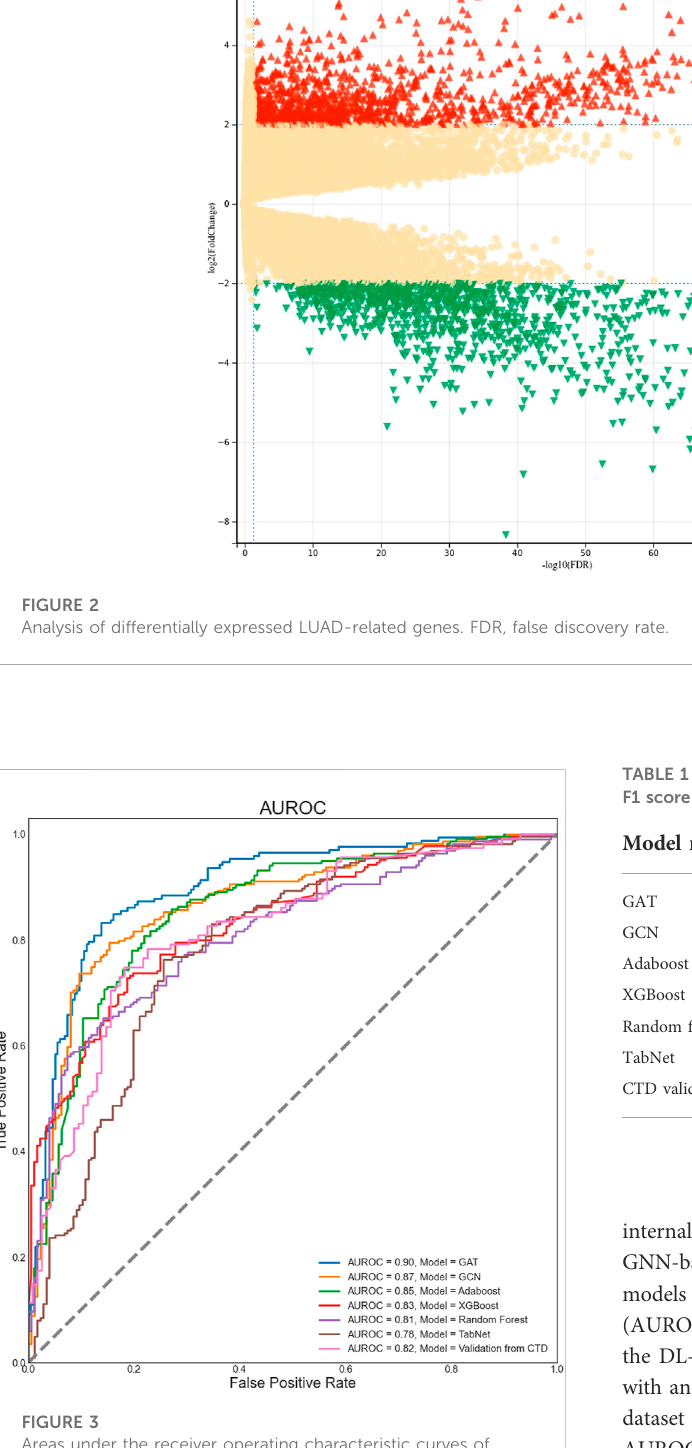
FIGURE 3 Areas under the receiver operating characteristic curves of the models. AUROC, area under the receiver operating characteristic curve; GAT, graph attention networks; GCN, graph convolutional network.